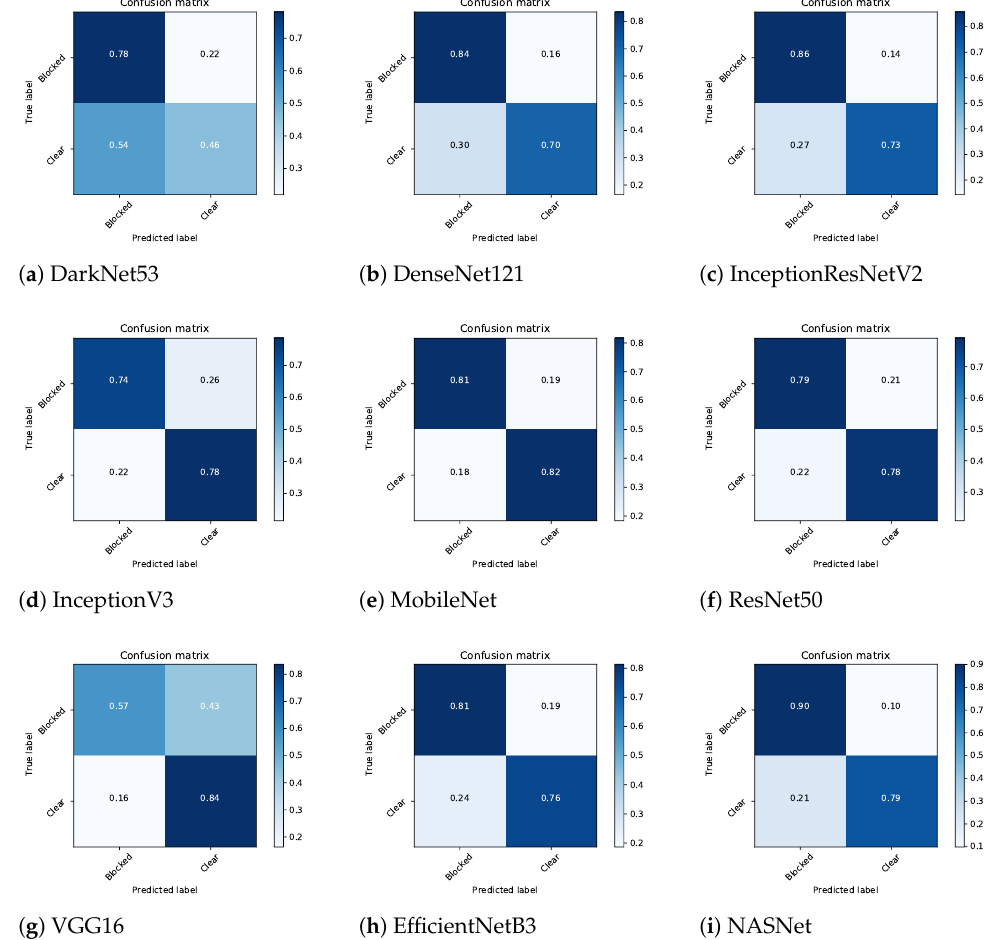
Figure 6. Confusion matrices of implemented CNN models for blockage detection (Conventional Train:Val:Test